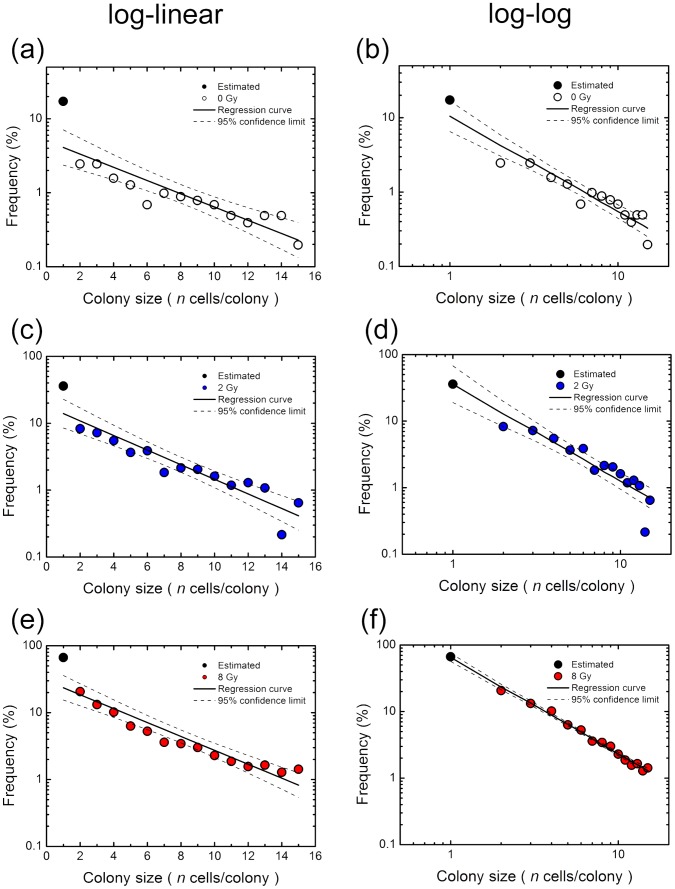
Regression analysis of experimental colony size distribution of abortive colonies at 0, 2 and 8 Gy.Two regression analyses on the log-linear (a, c and e) and log-log (b, d and f) plots were tested. Here, Equation 1 was used to estimate the frequency of 1-cell colony size (solid circle) from that of 2-cell colonies, assuming the similar probability of reproductive cell death for 1- and 2-cell colonies. The straight lines show the linear regression curves, and the dotted lines show the curves of a 95% confidence limit. Table 1 lists the numerical values of parameters obtained from the regression analysis of the data set.